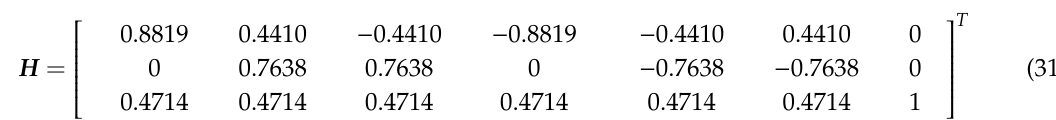
Figure 7. The redundant configuration of seven gyros.